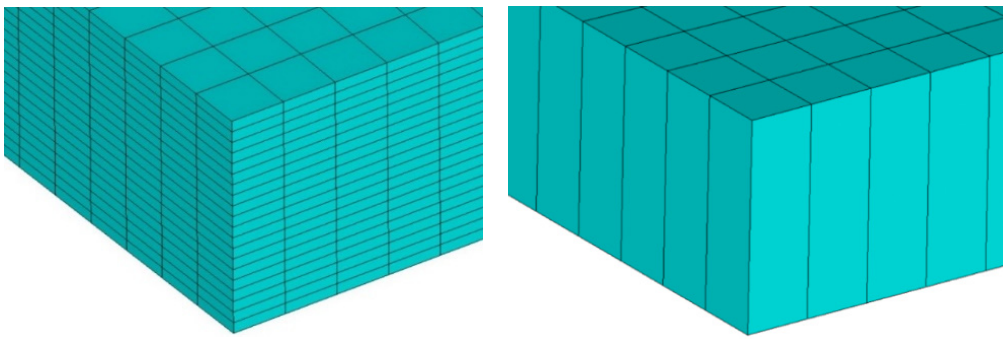
Figure 12. The 3D finite element model for static analysis.